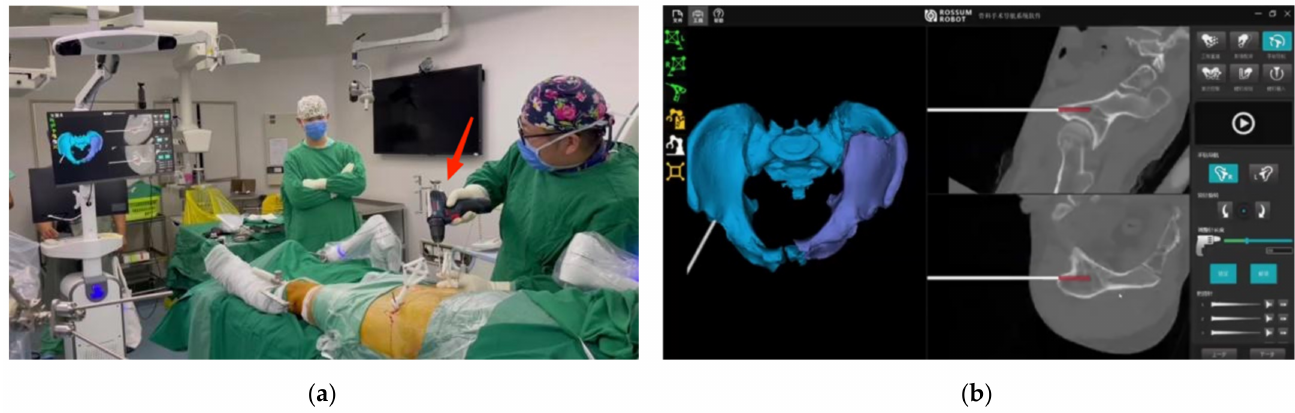
Figure 3. Gripping screws placement under navigation: ( a ) picture taken during gripping screws placement; ( b ) real time